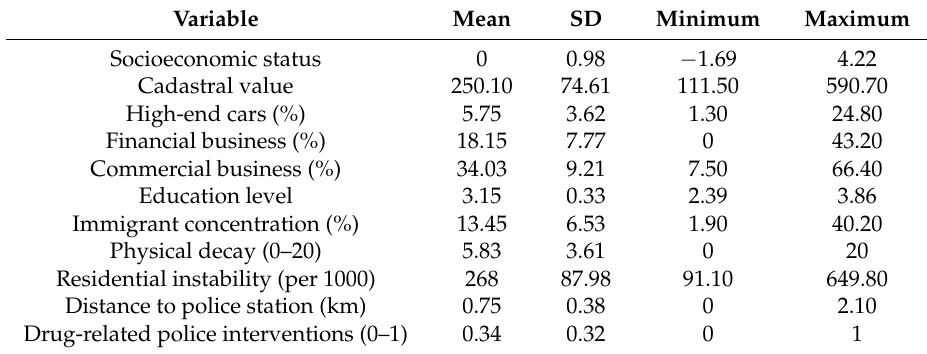
Table 1. Variables (mean, standard deviation, minimum and maximum values) at the census block group